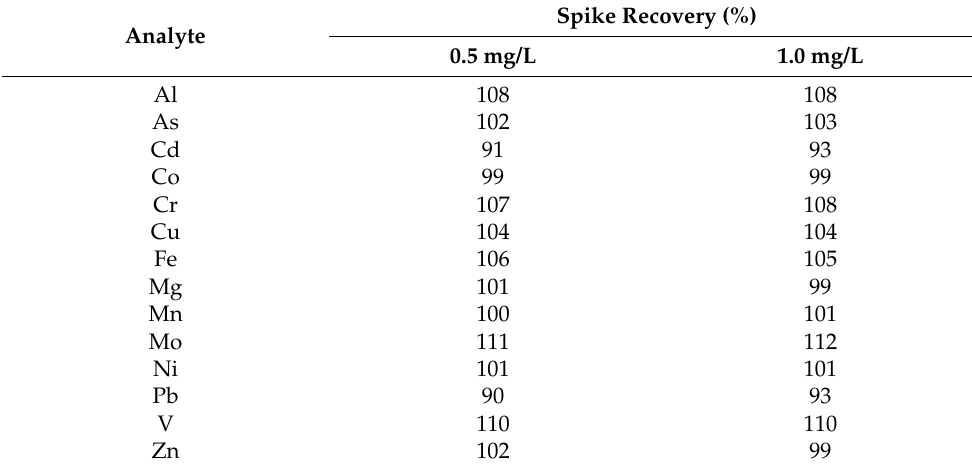
Table 1. Validation of methods using the spike concentrations of